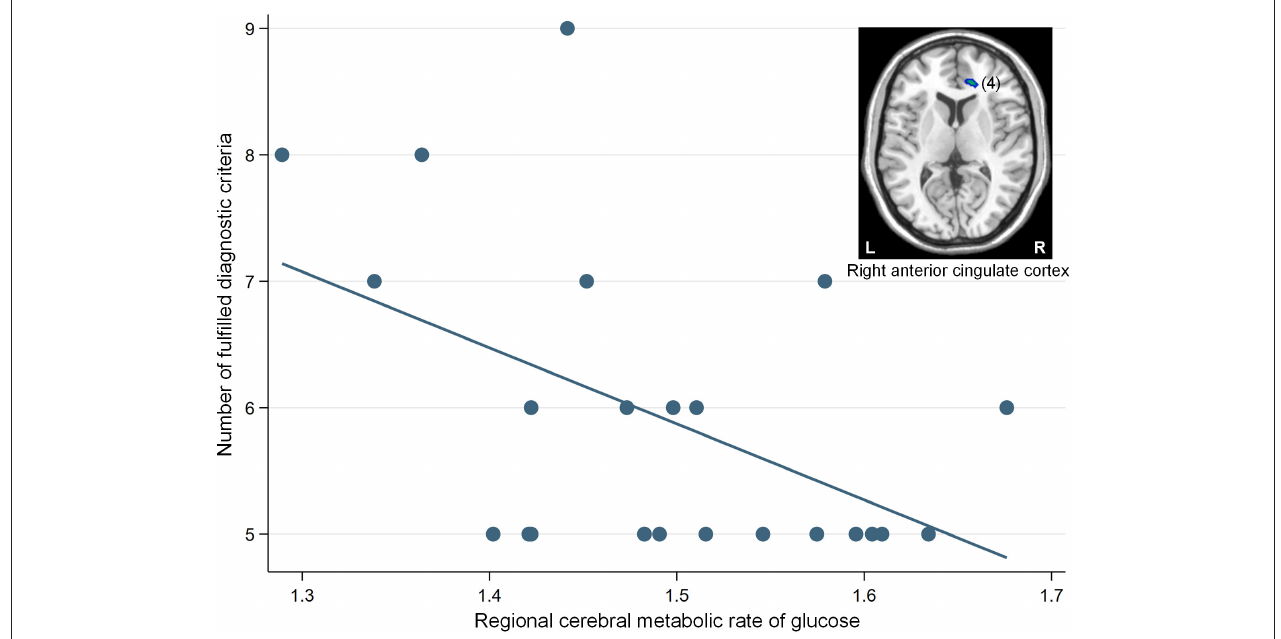
FIGURE 3 | A significant negative correlation between the regional cerebral metabolic rate of glucose in the right anterior cingulate cortex (cluster number 4) and the number of fulfilled diagnostic criteria for Internet gaming disorder (IGD) in participants with IGD ( β = − 0.50, p = 0.02). The number in parentheses show the cluster number listed in Table 2 . L, left; R,